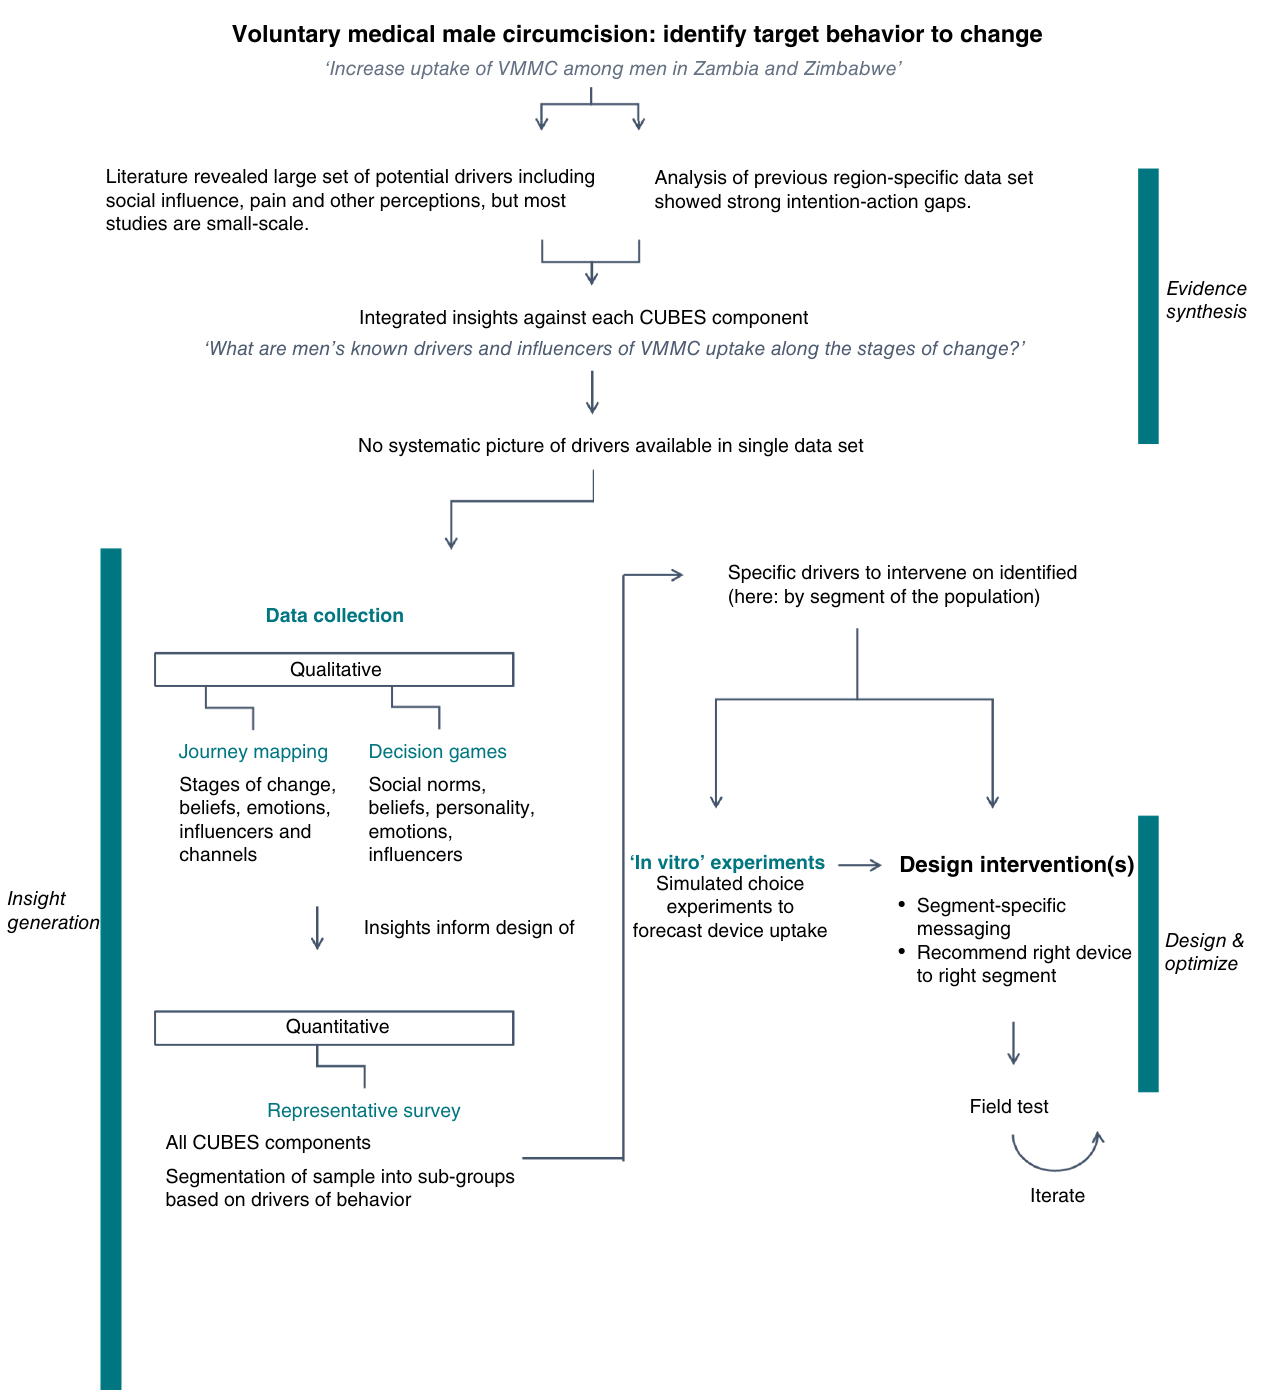
Figure 3. Process of evidence evaluation, insight generation, and intervention design and optimization in a VMMC program.